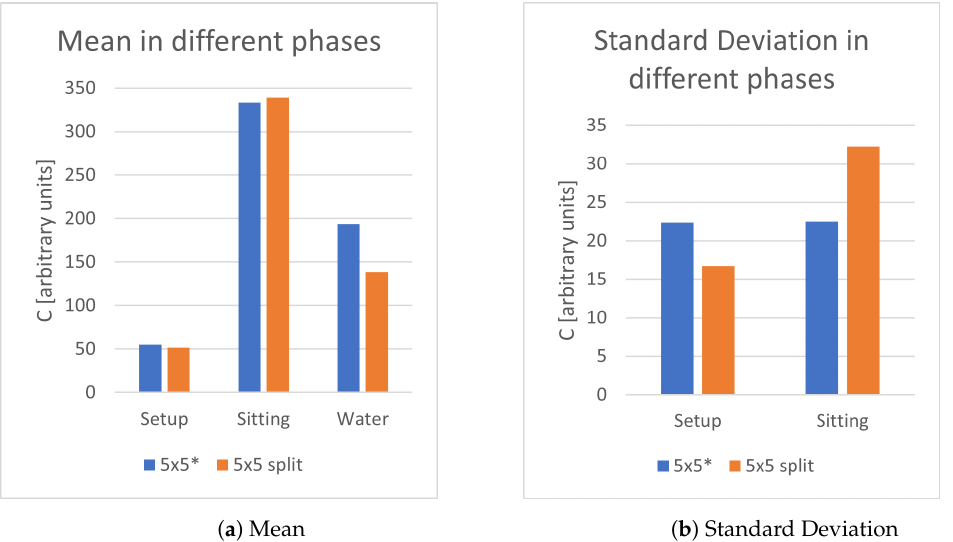
Figure 4. Study of split configurations. * Auto-calibration occurred during water frames.